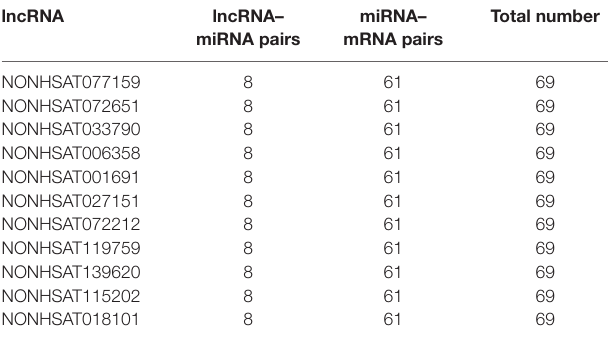
TABlE 3 | The number of lncRNA-miRNA and miRNA-mRNA pairs.